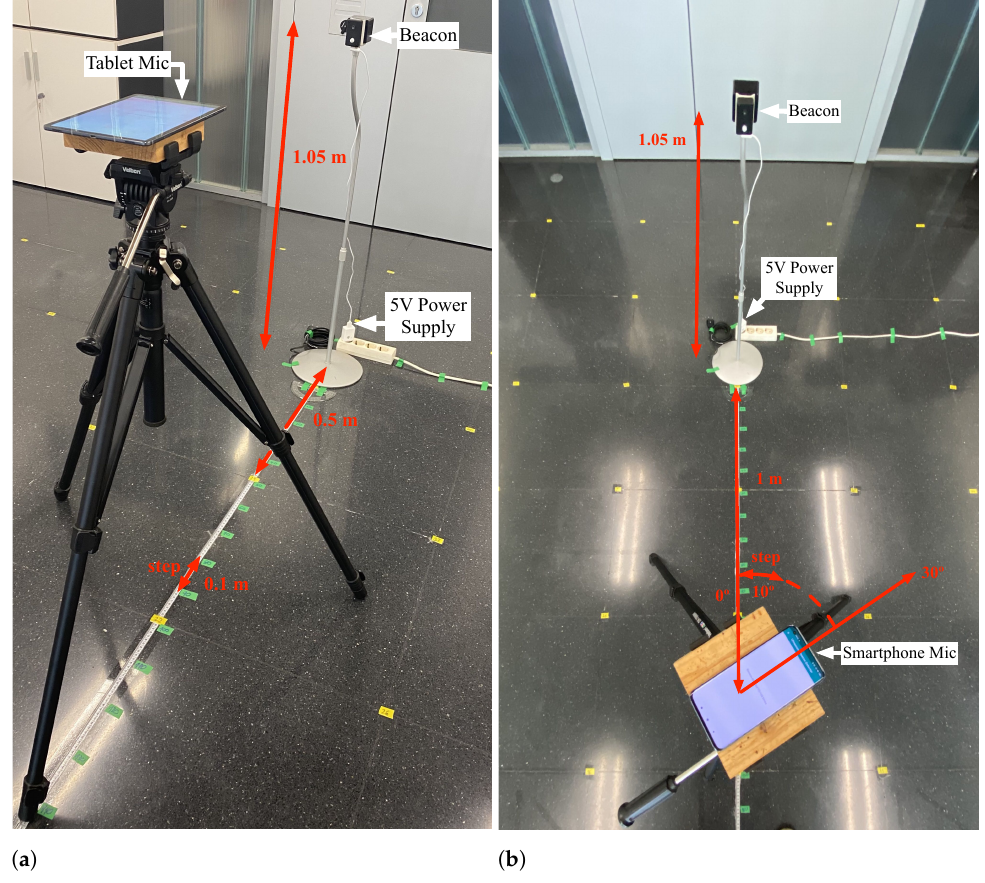
Figure 8. Sensing coverage experimental setups. ( a ) Device sensing with distance. ( b ) Device sensing with